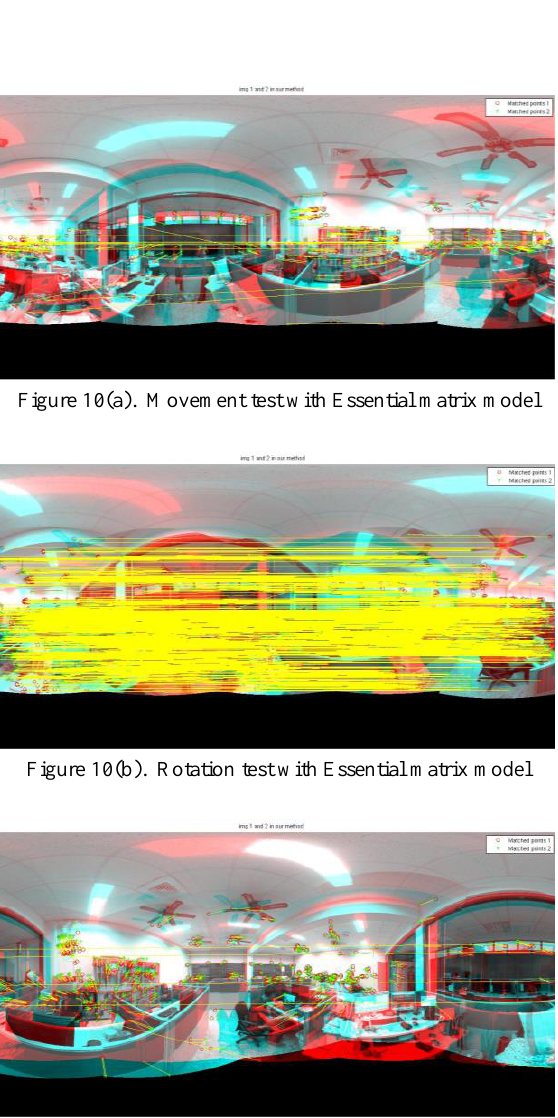
Figure 10(c). Oblique test with Essential matrix model